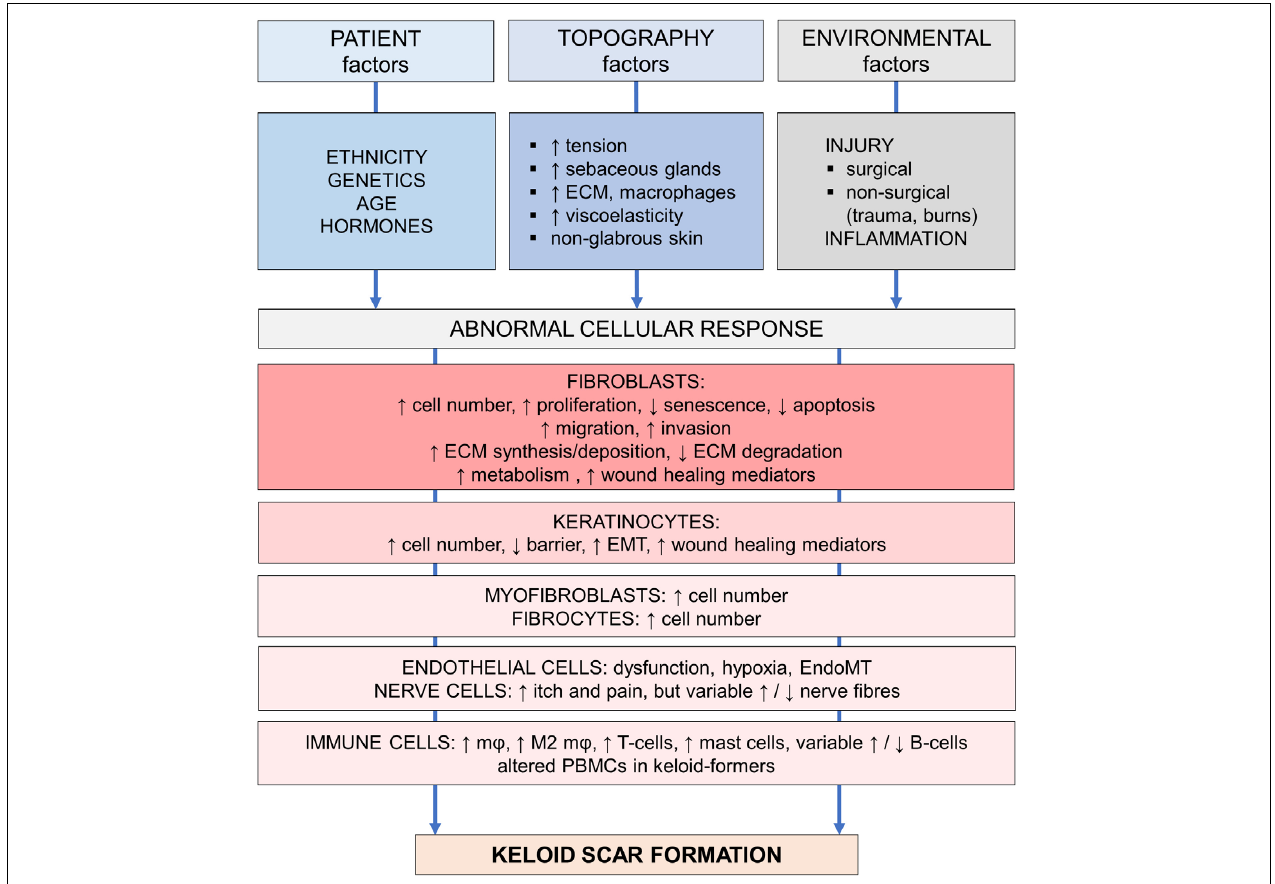
FIGURE 2 | Pathogenesis of keloid scarring. Overview of the various factors involved in keloid pathogenesis, adapted from Wolfram et al. (2009). This figure is meant to provide a provisionary framework to help organize the multitude of pathogenetic findings in a logical and systematic way. Abbreviations; ECM, extracellular matrix; EMT, epithelial-mesenchymal transition; EndoMT, endothelial-mesenchymal transition; m ϕ , macrophage; M2, alternatively activated, pro-fibrotic macrophage subtype; PBMCs, peripheral blood mononuclear cells. Figure first published in Limandjaja (2019), used with